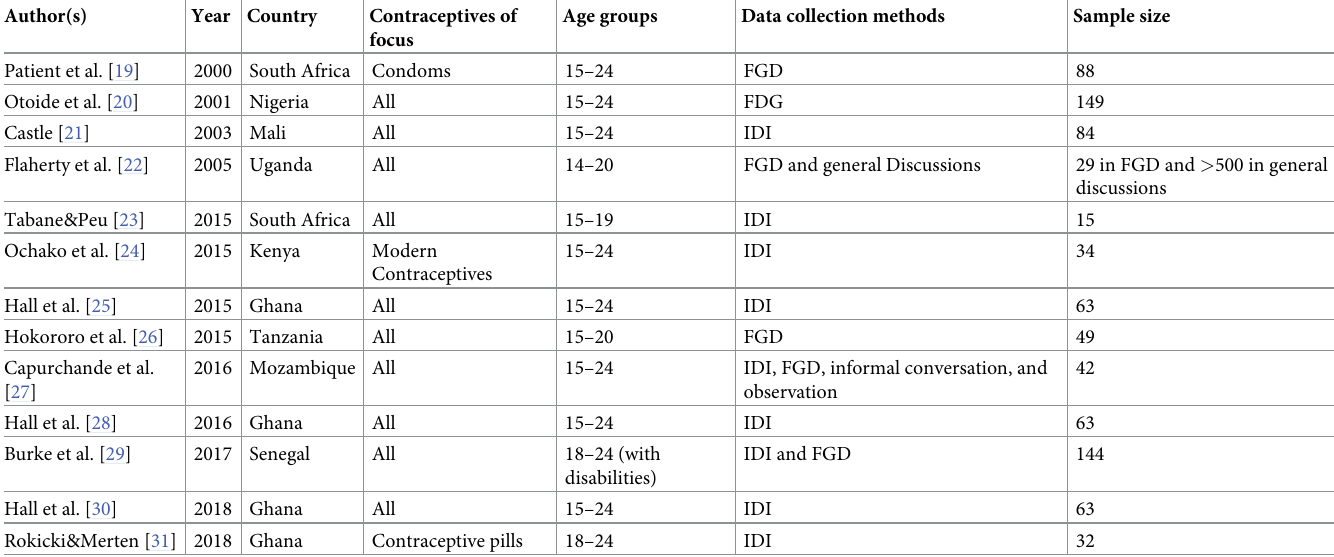
Table 1. Background of studies included in the final review.